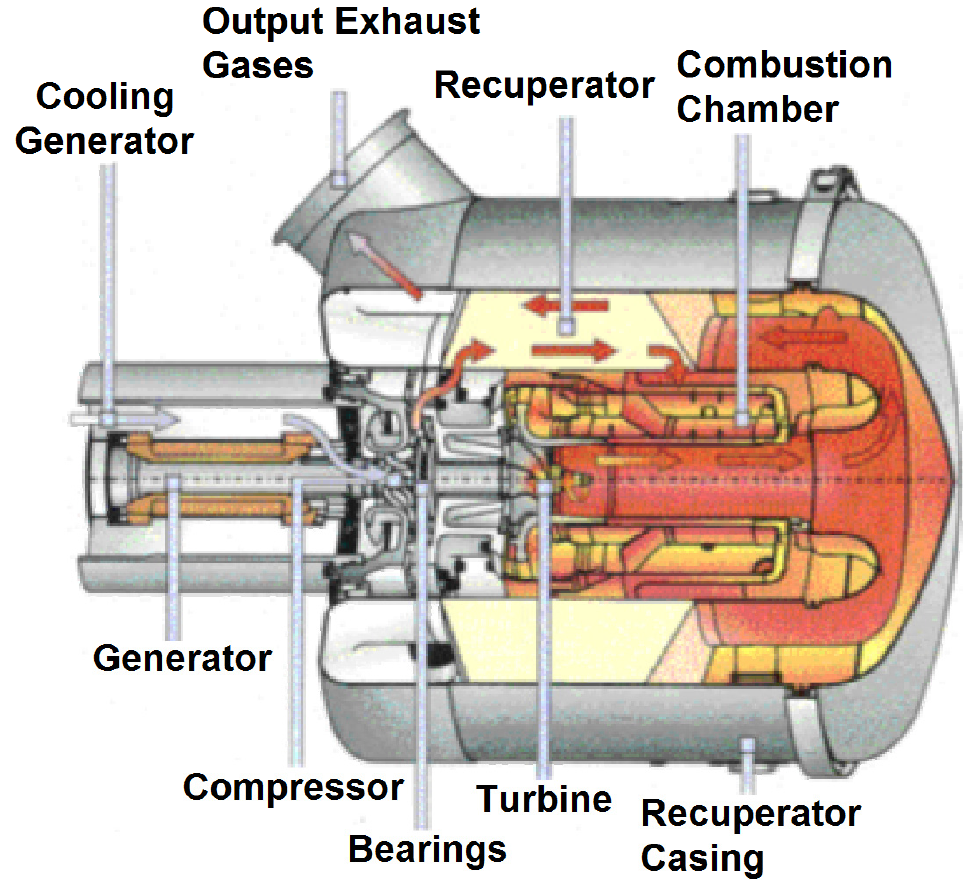
Figure 2. Power unit of a gas turbine unit with a built-in radial generator.